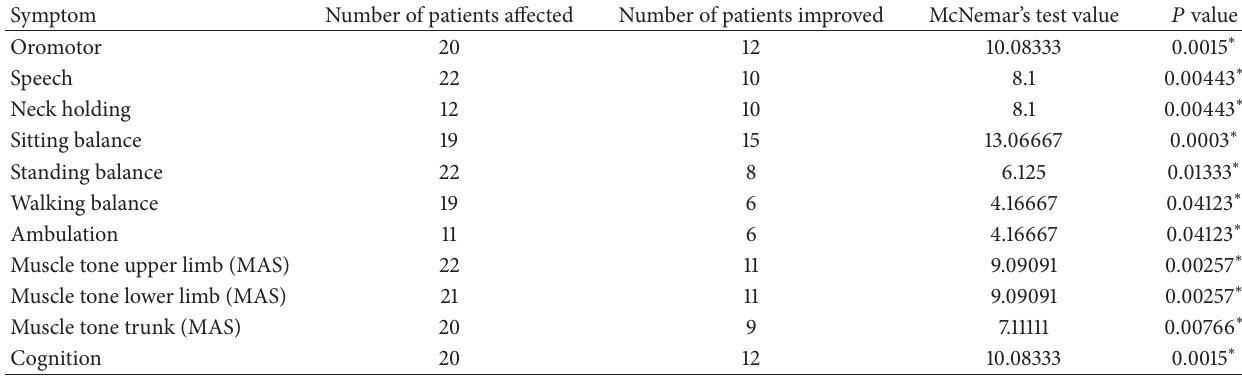
Table 5: Statistical analysis for each symptomatic improvement in quadriplegic CP using McNemar’s test.